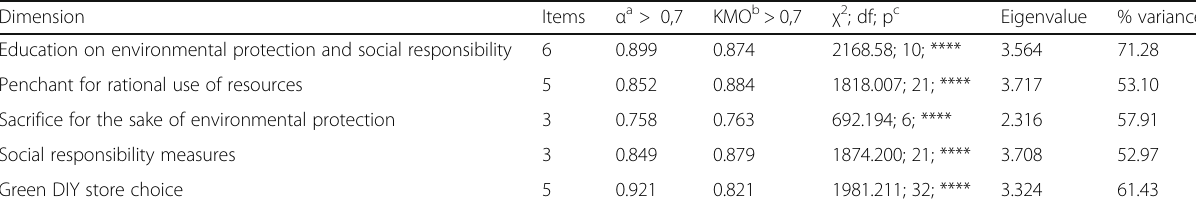
Table 1 Results of testing validity and reliability of collected data